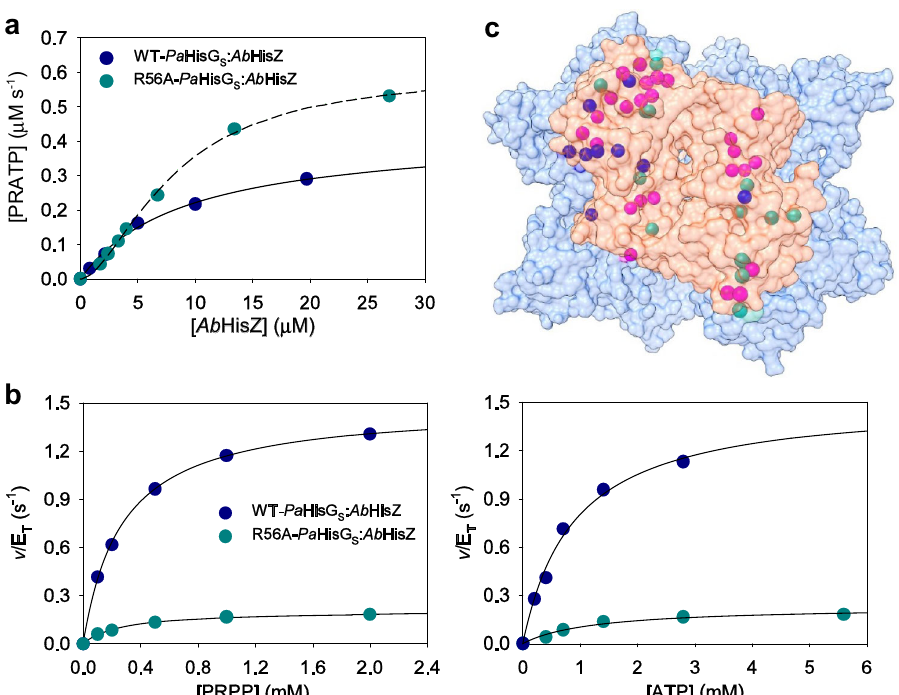
Fig.3|AllostericactivationofPaHisG S variantsby Ab HisZ.a Dependenceofrate of reaction catalysed by Pa HisG S variantson the concentration of Ab HisZ.Dataare themeanoftwoindependentmeasurements.Best fi